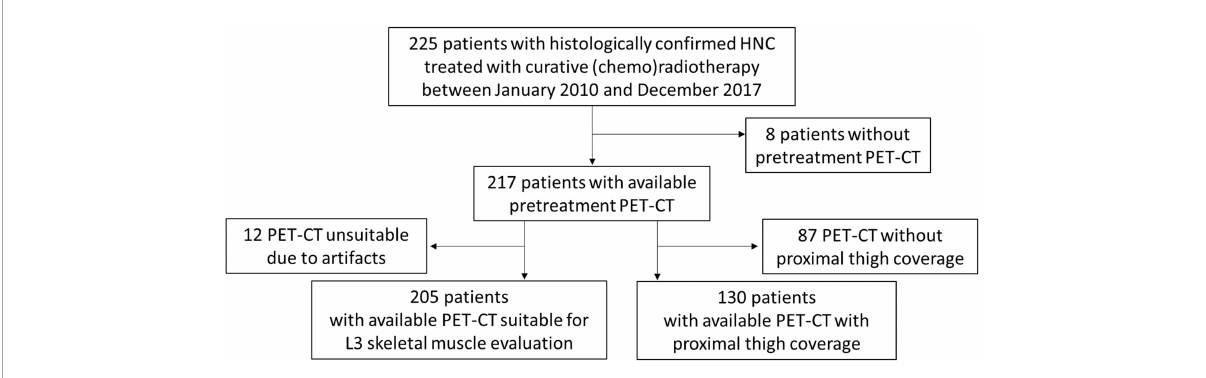
FIGURE1 Patient inclusion flow-chart. Flow-chart representing patient inclusion and subgroups of patients with available L3-and proximal thigh (PT)-computed tomography (CT) parameters of muscle quantity and quality.